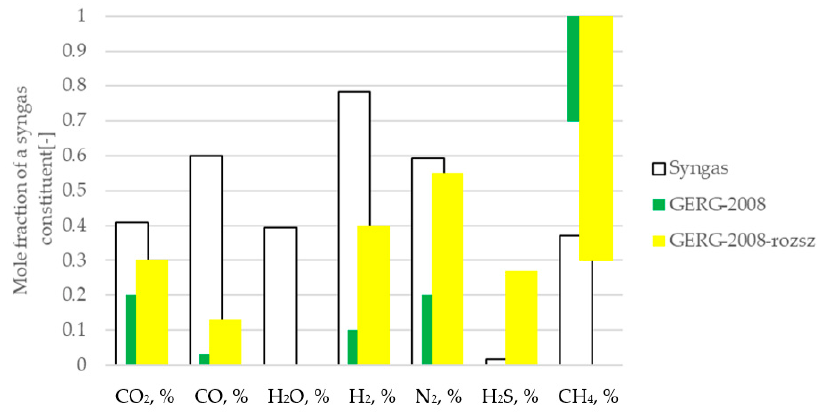
Figure 2. The range of mole fractions of the syngas components derived from modeling compared to the scope of the GERG-2008 method in the normal (GERG-2008) and extended (GERG-2008-rozsz) range of composition.